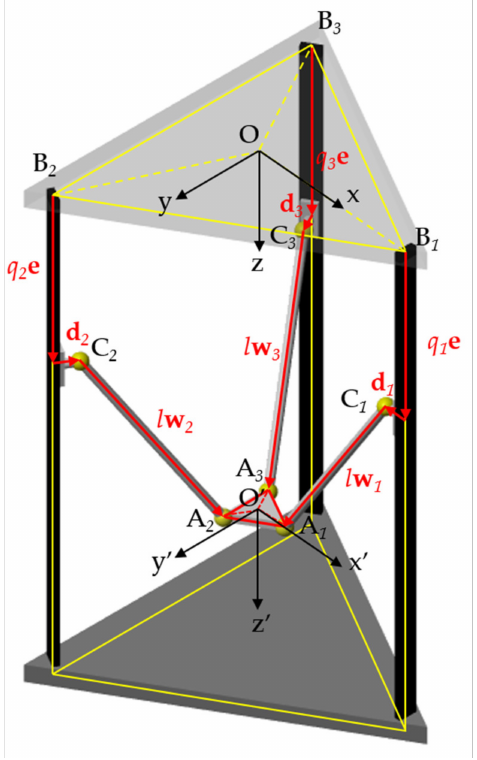
Figure 2. Geometrical model of the 3-PUU parallel robot. The reference frame O(x,y,z) of the base platform is located at the center of the equi- lateral triangle B 1 B 2 B 3 , whose vertices lie on a circumference with center O and radius R , while the reference frame O’(x’,y’,z’) of the moving platform is located at the center of the equilateral triangle A 1 A 2 A 3 , whose vertices lie on a circumference with center O’ and radius r . The unit vector e , perpendicular to the plane of the triangle B 1 B 2 B 3 , defines the direction of the three prismatic joints, and the vector of the internal coordinates q = [ q 1 , q 2 , q 3 ] T is composed by the distances of the centers of the three sliders from the points B 1 , B 2 , and B 3 ; consequently, the three vectors, q 1 e , q 2 e , and q 3 e , represent the displacements of the sliders’ centers with respect to B 1 , B 2 , and B 3 . For constructive reasons, the centers of the universal joints mounted on the sliders do not lie on the prismatic joints’ axes, but are shifted by the three vectors d i , i = 1 . . . 3, with equal module d and the direction of the vector (O–B i